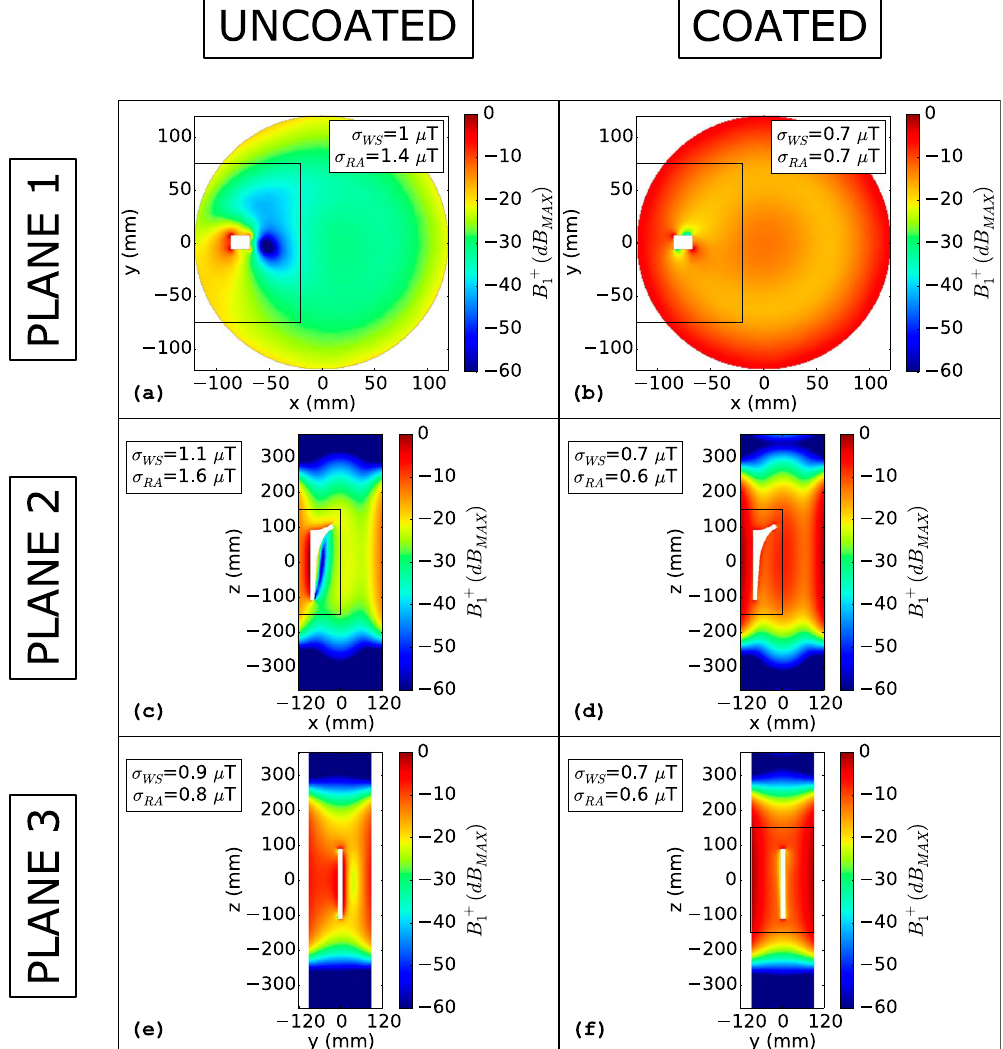
Figure 6. B 1 + ( dB MAX ): Lateral metallic hip prosthesis. B 1 + ( dB MAX ) evaluated for the realistic hip prosthesis model plunged into the phantom in a lateral position ( − 80 mm from the phantom centre to the prosthesis base centre). Figures ( a ) and ( b ) depict the uncoated and coated object situation, respectively, for the transverse plane that cuts the phantom in two equal parts along the longitudinal direction. Figures ( c ) and ( d ) depict the uncoated and coated object condition, respectively, for the coronal plane that cuts the phantom in two equal parts. Figures ( e ) and ( f ) depict the uncoated and coated object condition, respectively, for the sagittal plane that passes through the prosthesis base centre. The rectangular areas represent the reduced areas in which the standard deviation ( σ RA ) was computed. σ WS represents the standard deviation computed on the whole